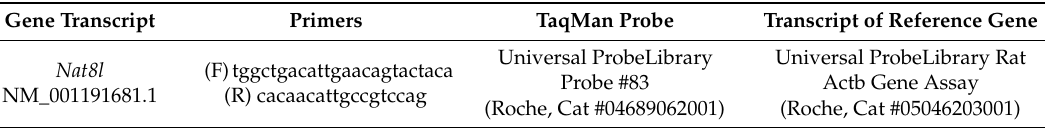
Table 2. List of primers and TaqMan probes used in this